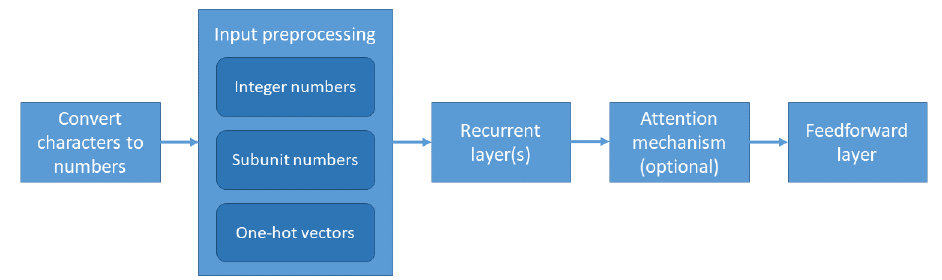
Figure 1. Pipeline of proposed